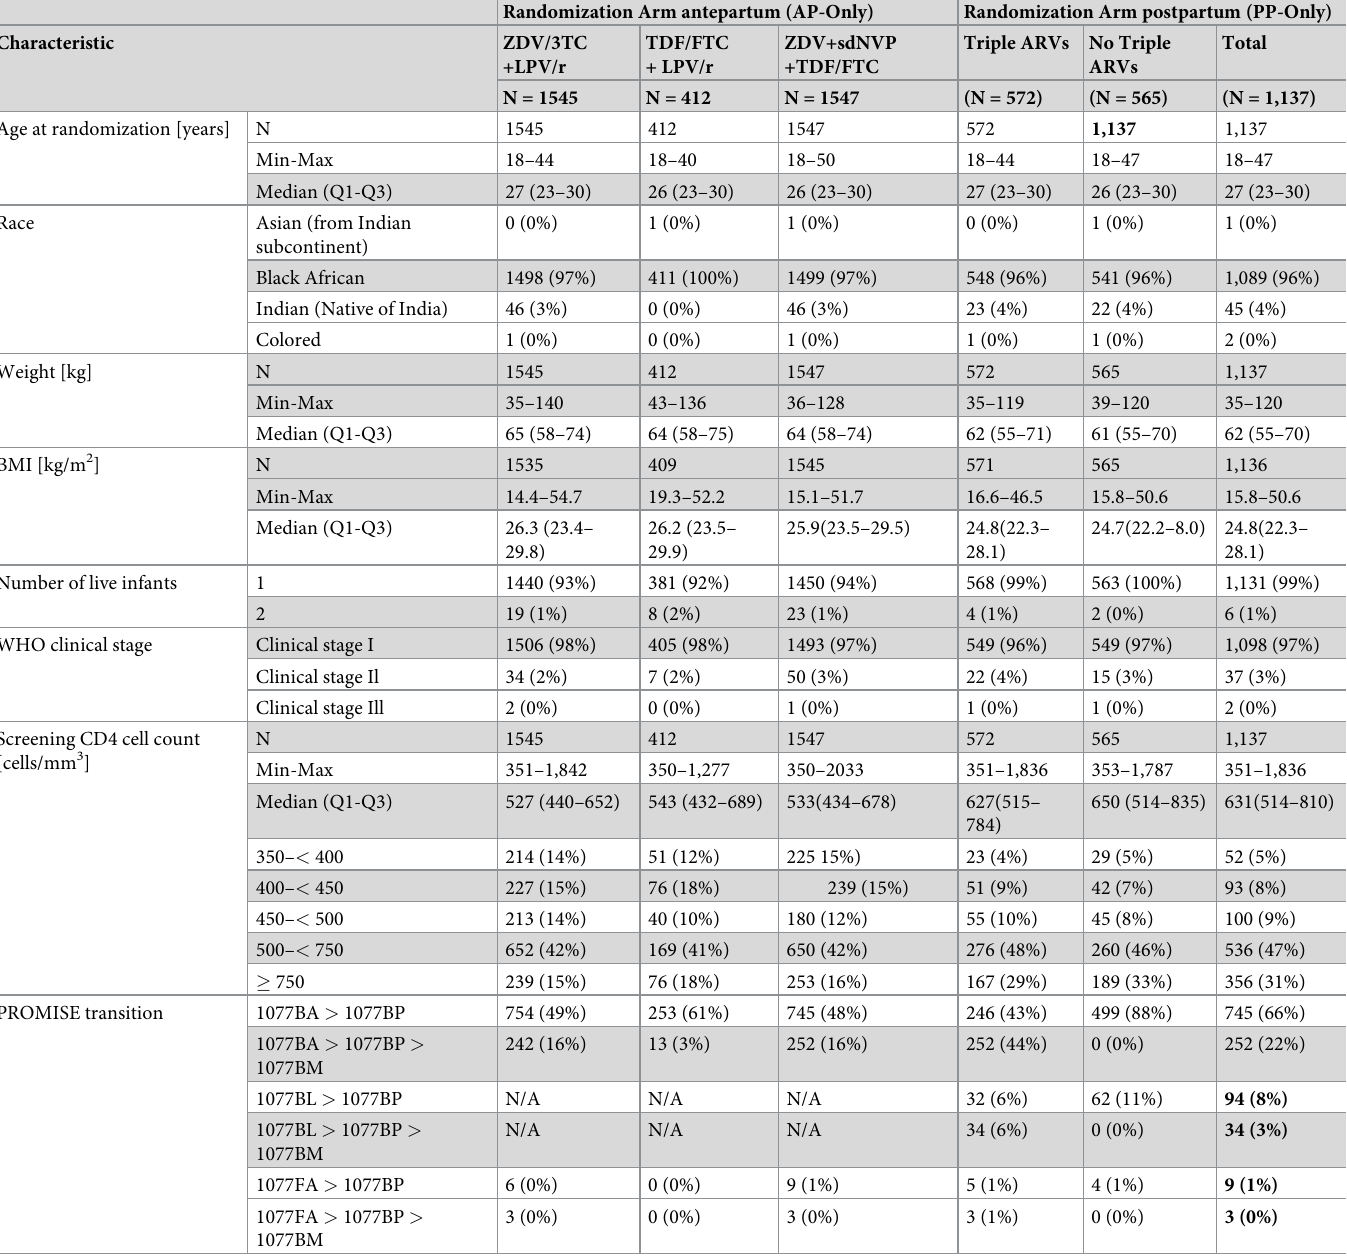
Table 1. Baseline characteristics 1077BF/1077FF subgroup AP-only and PP-only cohorts. Randomization Arm antepartum (AP-Only) Randomization Arm postpartum